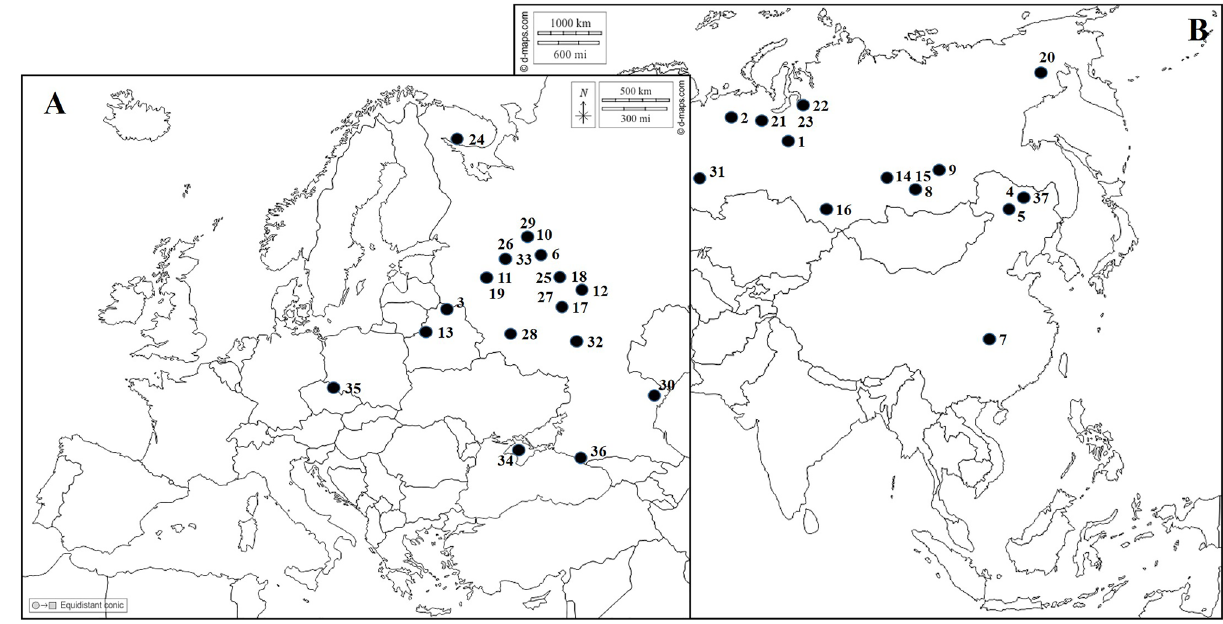
Figure 5. The Map showing location (black dots with numbers) of the Sparganium specimens analyzed in this study. Specimens are numbered as in Supplementary S3. (The basis of the maps were taken from d-maps.com (http:// data. danet soft. com/d- maps. com/) Europe ( A ) (https://d- maps. com/ carte. php? num_ car= 2233& lang= en) and Asia ( B ) (https://d- maps. com/ carte. php? num_ car= 55& lang= en), the image is changed using Free Software for Digital Photo Editing Paint.NET 4.3.11 https:// paint net. ru/ downl